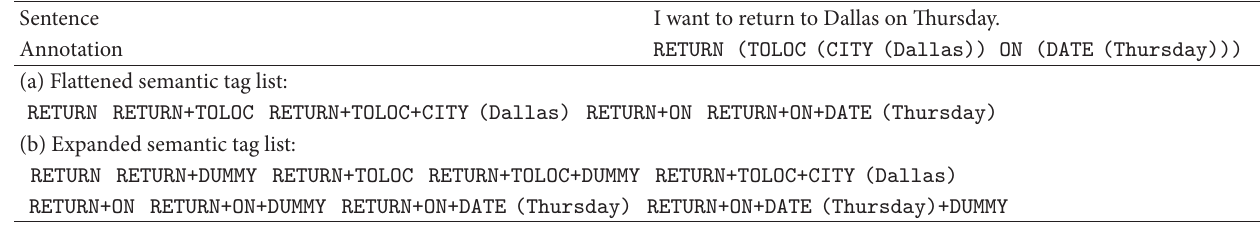
Figure 1: The proposed learning framework of training statistical models from abstract semantic annotations. Table 1: Abstract semantic annotation and its flattened semantic tag